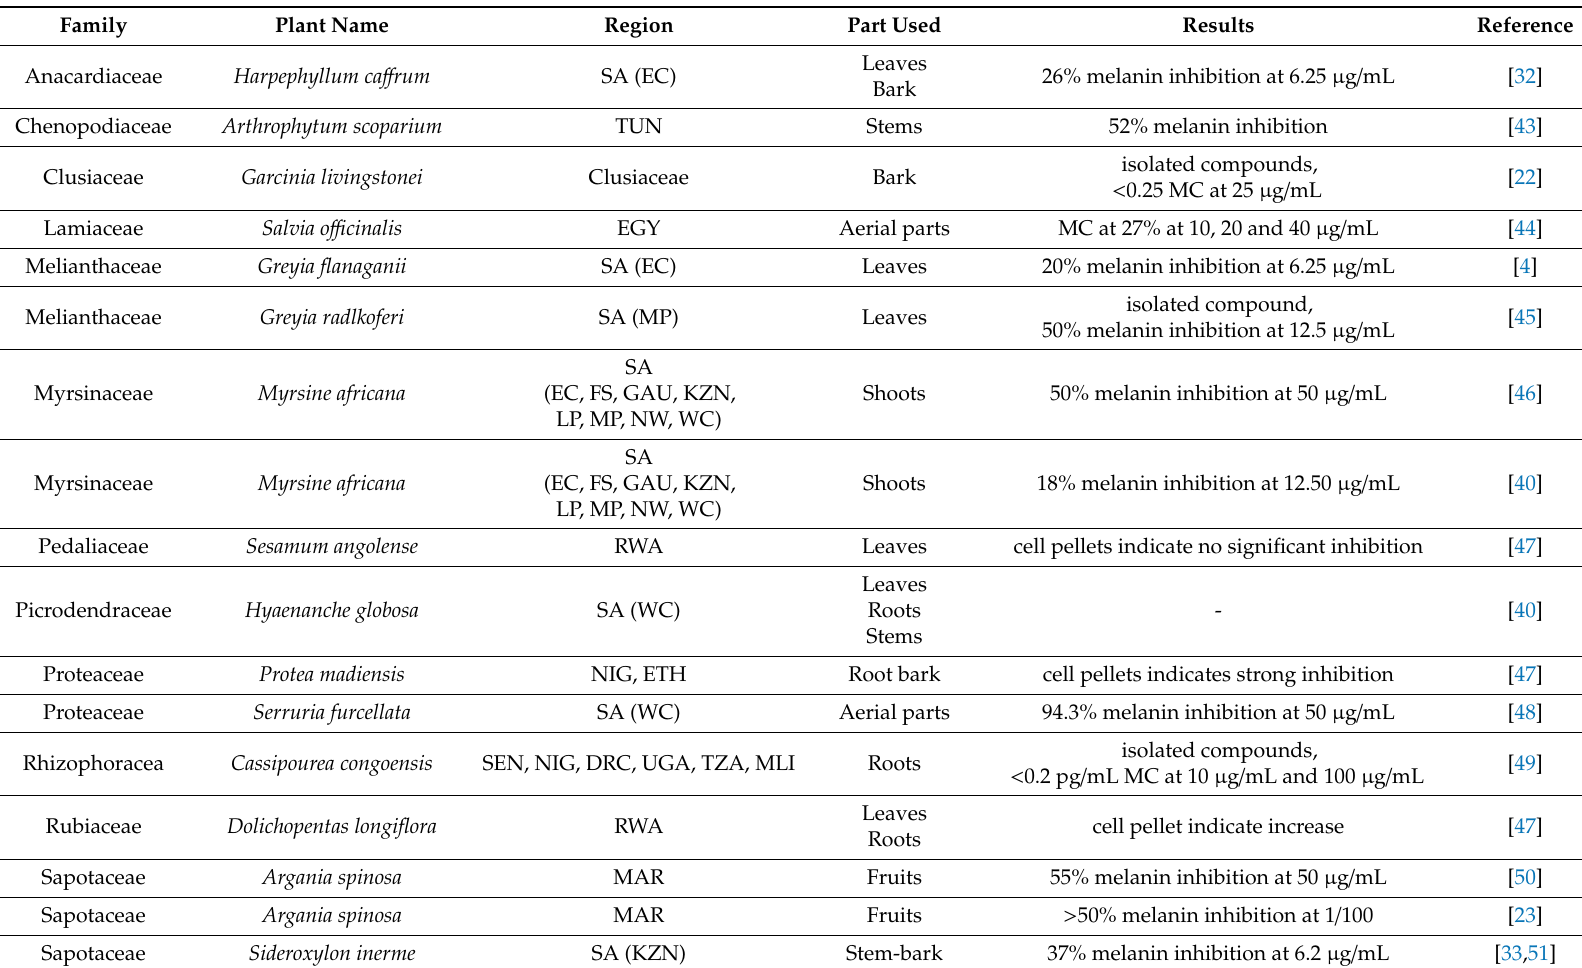
Table 1. Summary of the plant species identified and their melanin